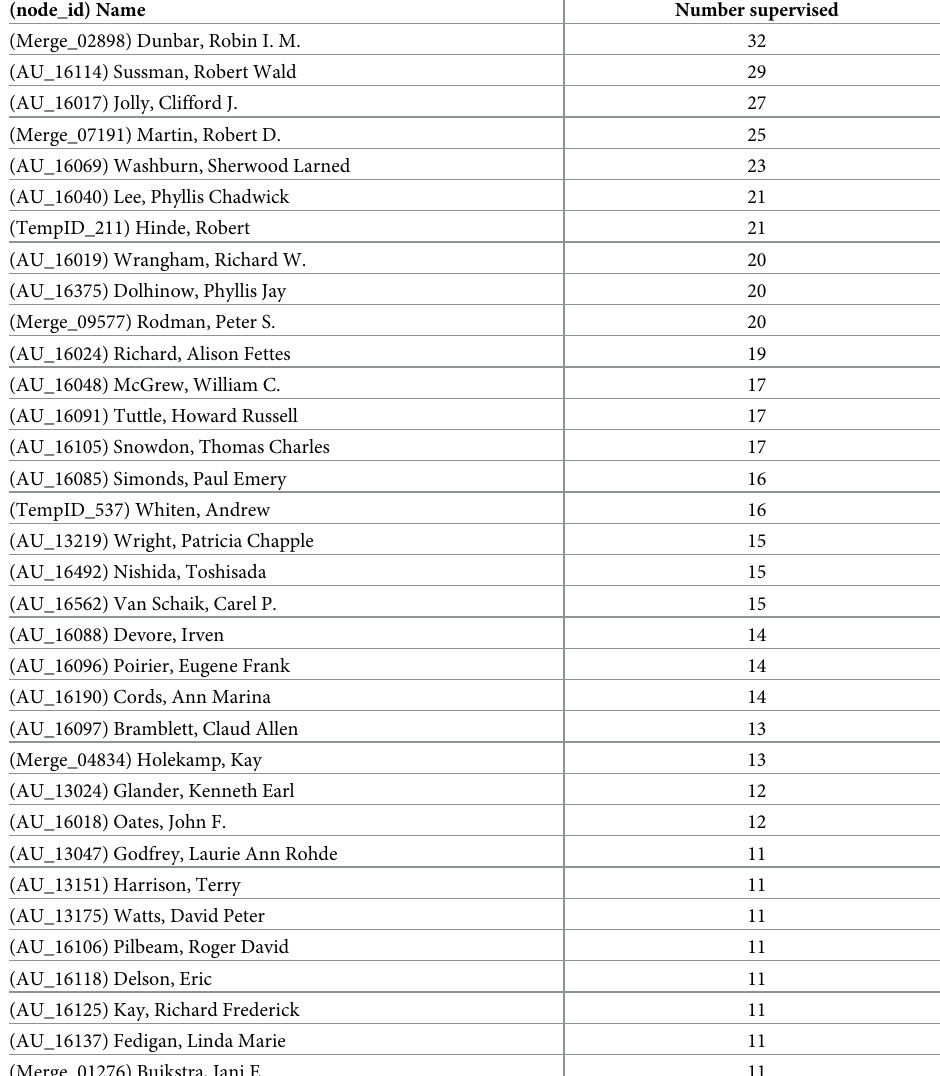
Table 2. Top supervisors in the field of primatology by number of supervisees. Only those with more than 10 stu- dents are